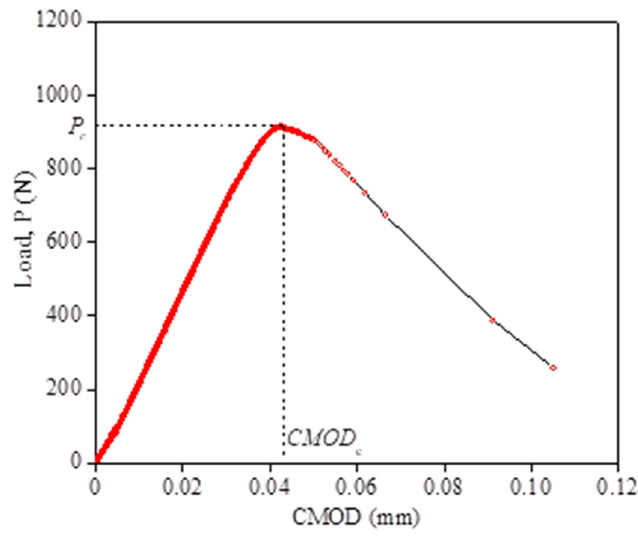
Figure 8. Typical wedge split load–CMOD